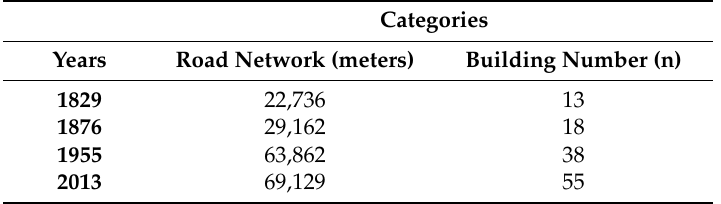
Table 2. Variations of the linear extension of the road network and of building number.